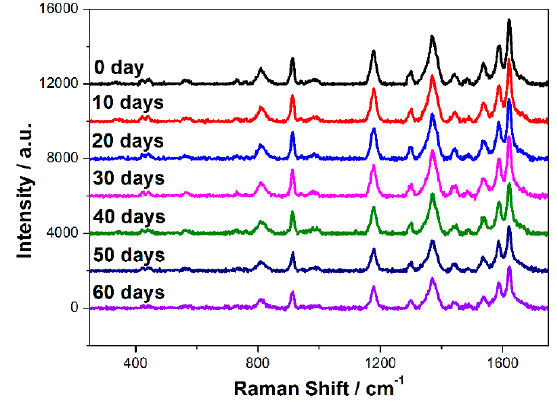
Figure 5. The SERS stability of Au NPs@MoS 2 QDs.